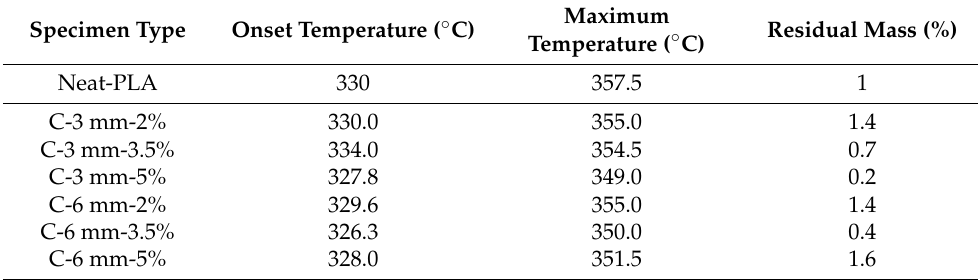
Table 5. TGA analysis data.